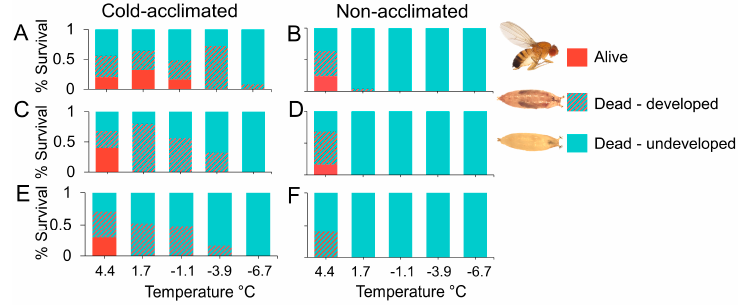
Figure 4. Percent pupal survival (y-axis) of cold-acclimated (blue bars) and non-acclimated (red bars) D. suzukii held at 25 ( A ), 4.4 ( B ), 1.87 ( C ), − 1.11 ( D ), − 3.87 ( E ), and − 6.67 °C ( F ) for up to two weeks (x-axis).